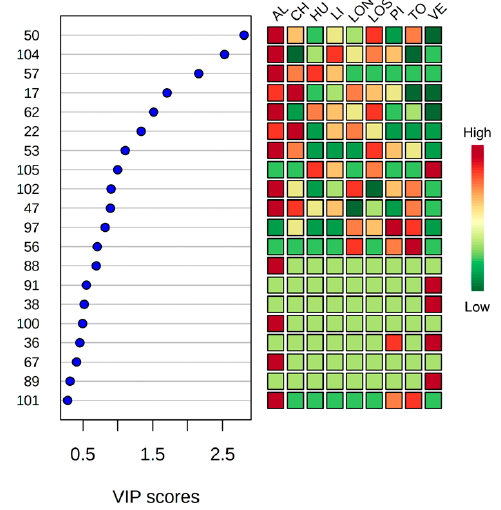
Figure 3. Representation of the twenty most important metabolites ranked by PLS-DA VIP score. The mini heatmap on the right indicates variations of their relative intensities in 9 different samples of Arctostaphylos uva-ursi